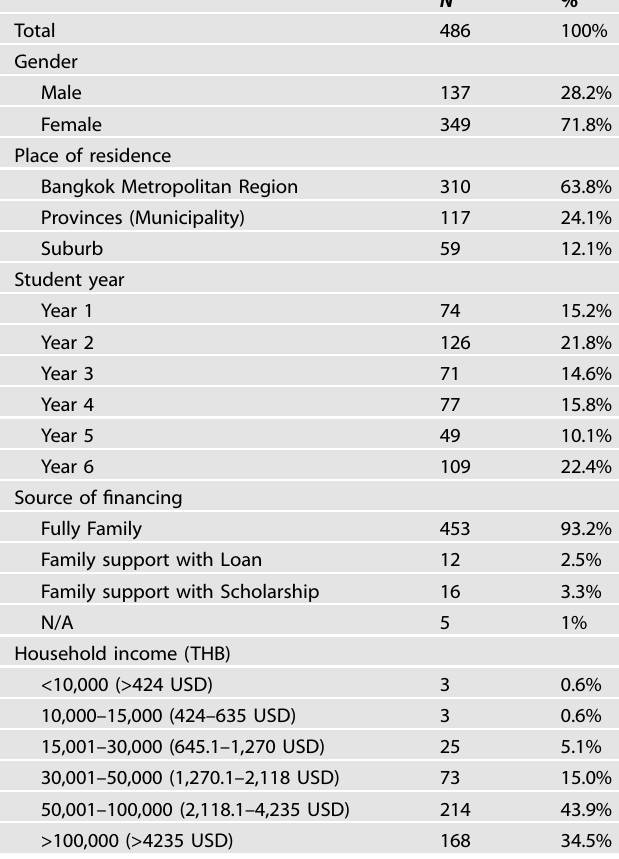
Table 1. Characteristics and Economic background ( N =